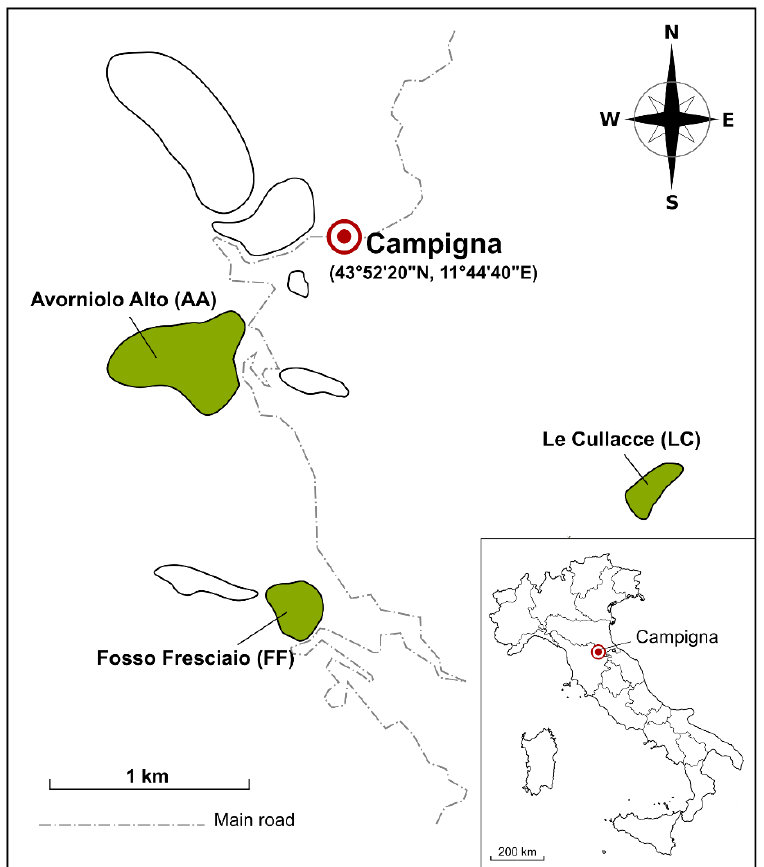
Figure 1. Map of F. paralugubris populations in the Campigna Biogenetic Nature Reserve. Green areas indicate the three populations analyzed in this study and white areas are populations not analyzed